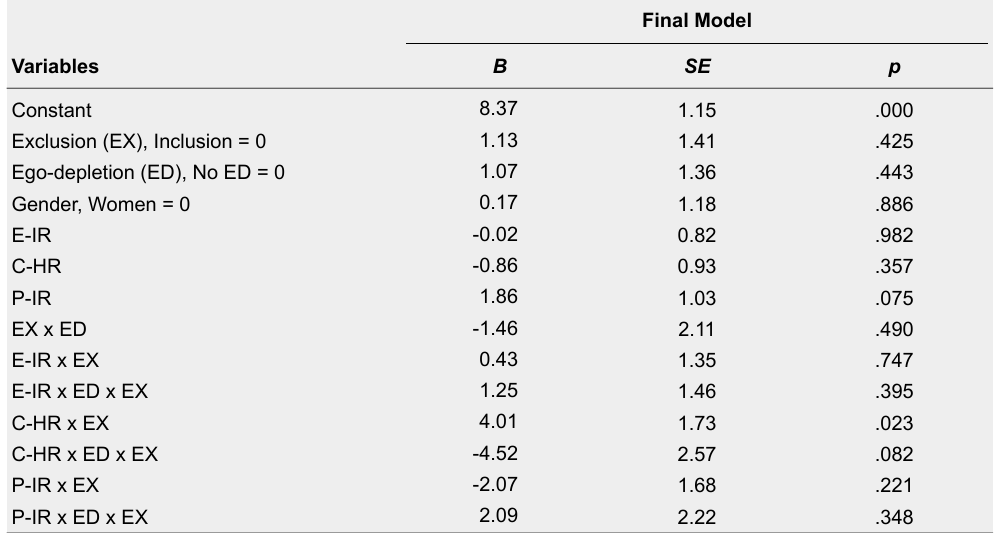
Hierarchical Multiple Regressions Models for Readiness for Aggression on Displaced Aggressive Behavior